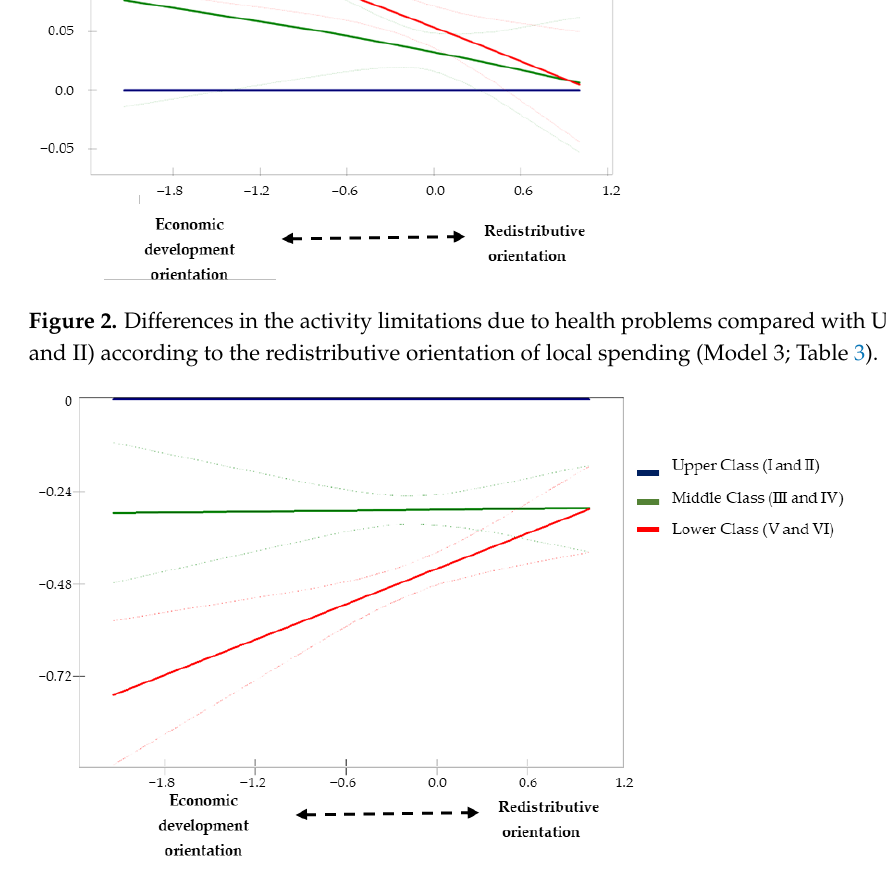
Figure 3. Differences in the adoption of healthy practices compared with Upper Class (I and II) according to the redistributive orientation of local spending (Model 3; Table 4).